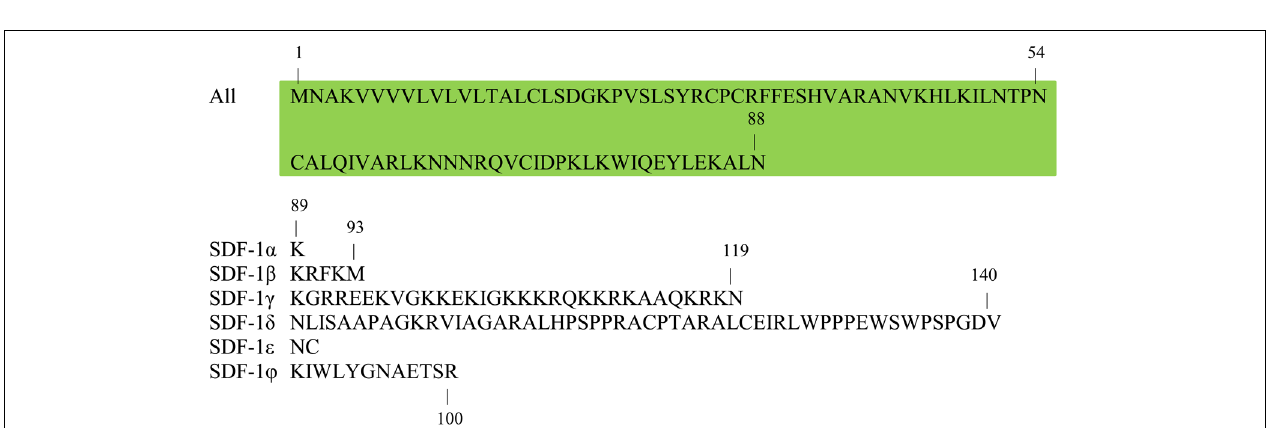
FIGURE 1 | Sequence similarities of different CXCL12/SDF-1 isoforms. Six isoforms of CXCL12/SDF-1 have been described to date, which share a common N-terminal amino acid sequence, but a distinct C-terminus. Shown is the single letter amino acid code for all CXCL12 isoforms, with the shared